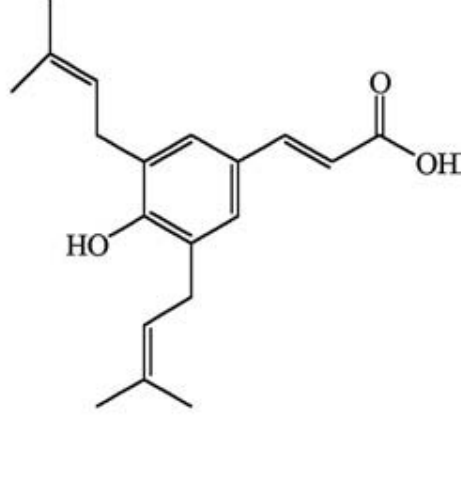
Figure 1. Chemical structure of artepillin